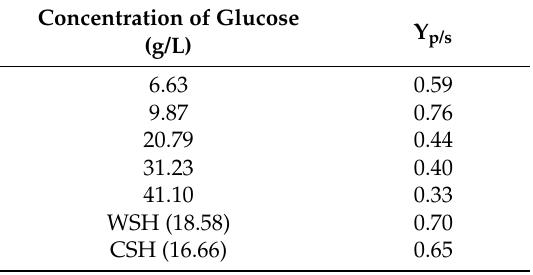
Table 3. Calculation of yield coefficients for different glucose concentrations and lignocellulosic biomass